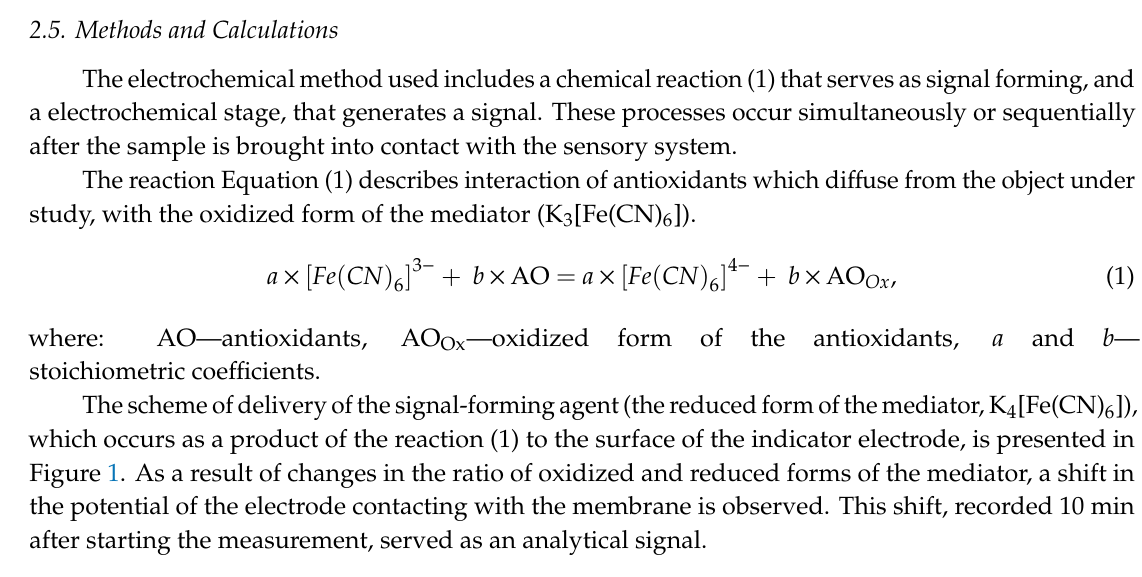
the potential of the electrode contacting with the membrane is observed. This shift, recorded 10 min after starting the measurement, served as an analytical signal.